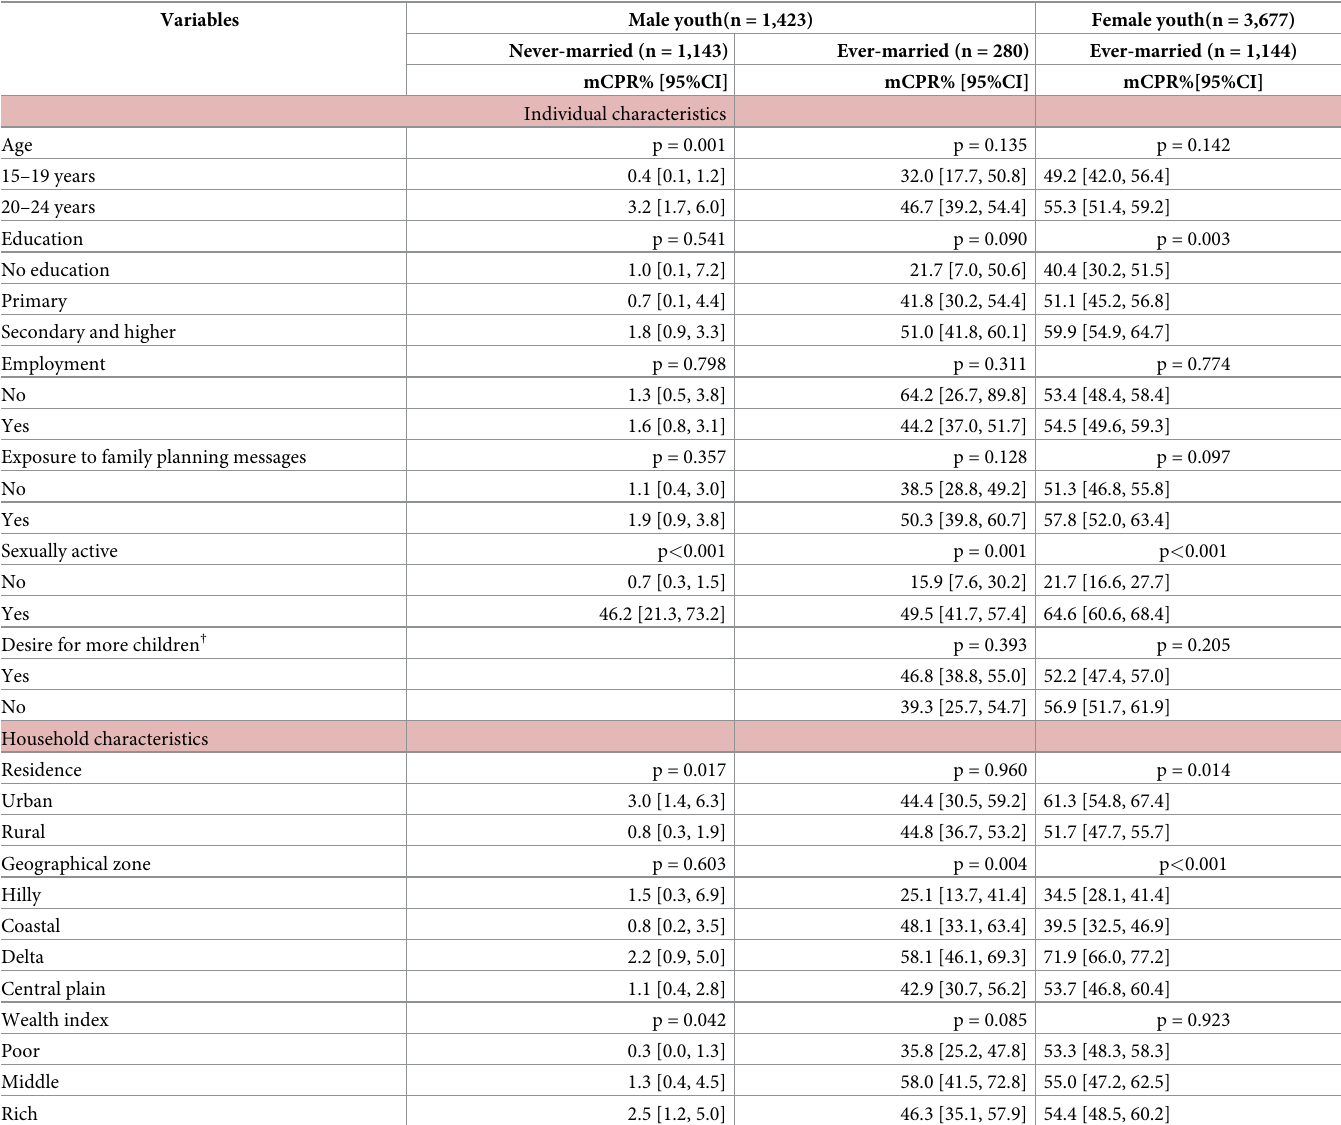
Table 4. The association between modern contraceptive methods utilization by background characteristics among youth in Myanmar (Bivariate analysis).